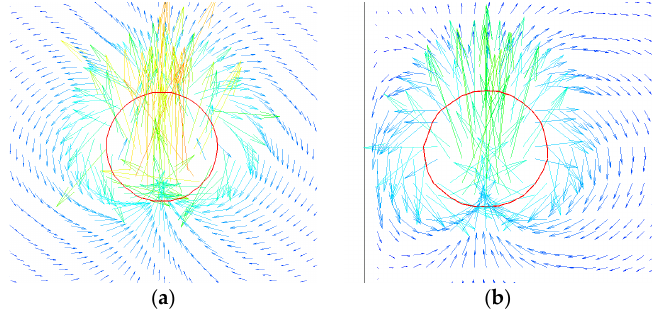
Figure 9. The velocity vector generated by the near ‐ wall bubble and the central bubble rising 10 ms: ( a ) The central bubble, ( b ) The near ‐ wall